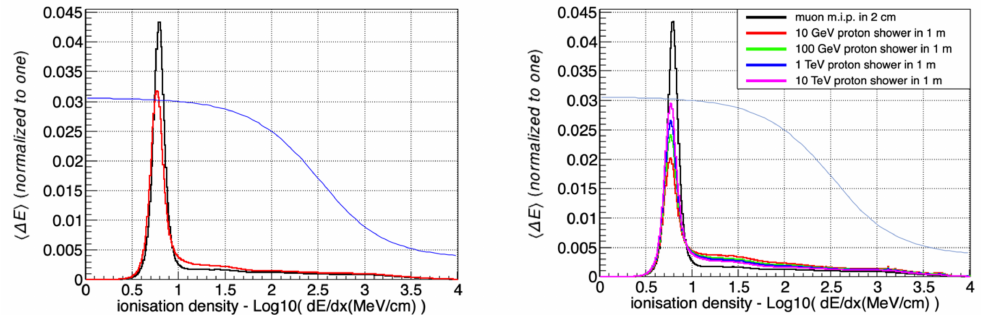
Figure 6. ( Left panel ) Ionization density profile of 10 GeV electrons (red line), MIP (black line), and the light-emission efficiency of LYSO (blue line) in an arbitrary unit. ( right panel ) Ionization density profile of protons at different energies (colored tick lines), MIP (black line), and the light-emission efficiency of LYSO (thin line) in an arbitrary unit [16].